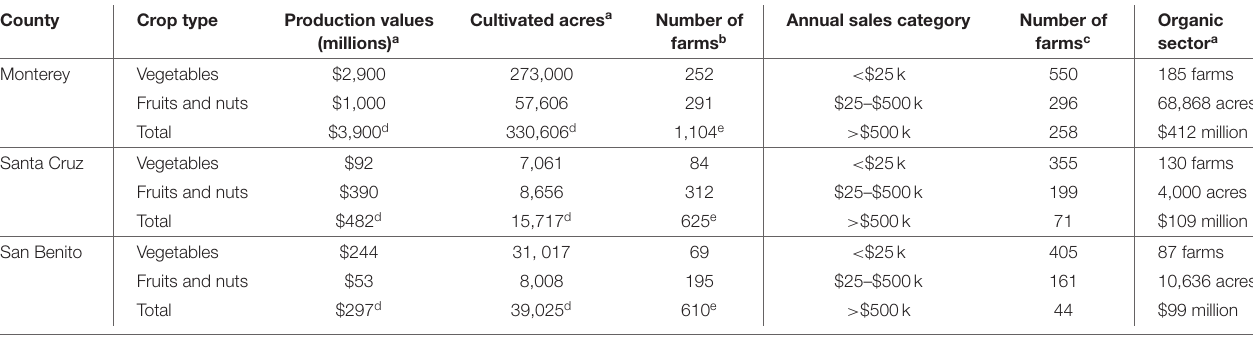
TABLE 1 | Central coast agriculture: selected production statistics for Monterey, Santa Cruz, and San Benito Counties.